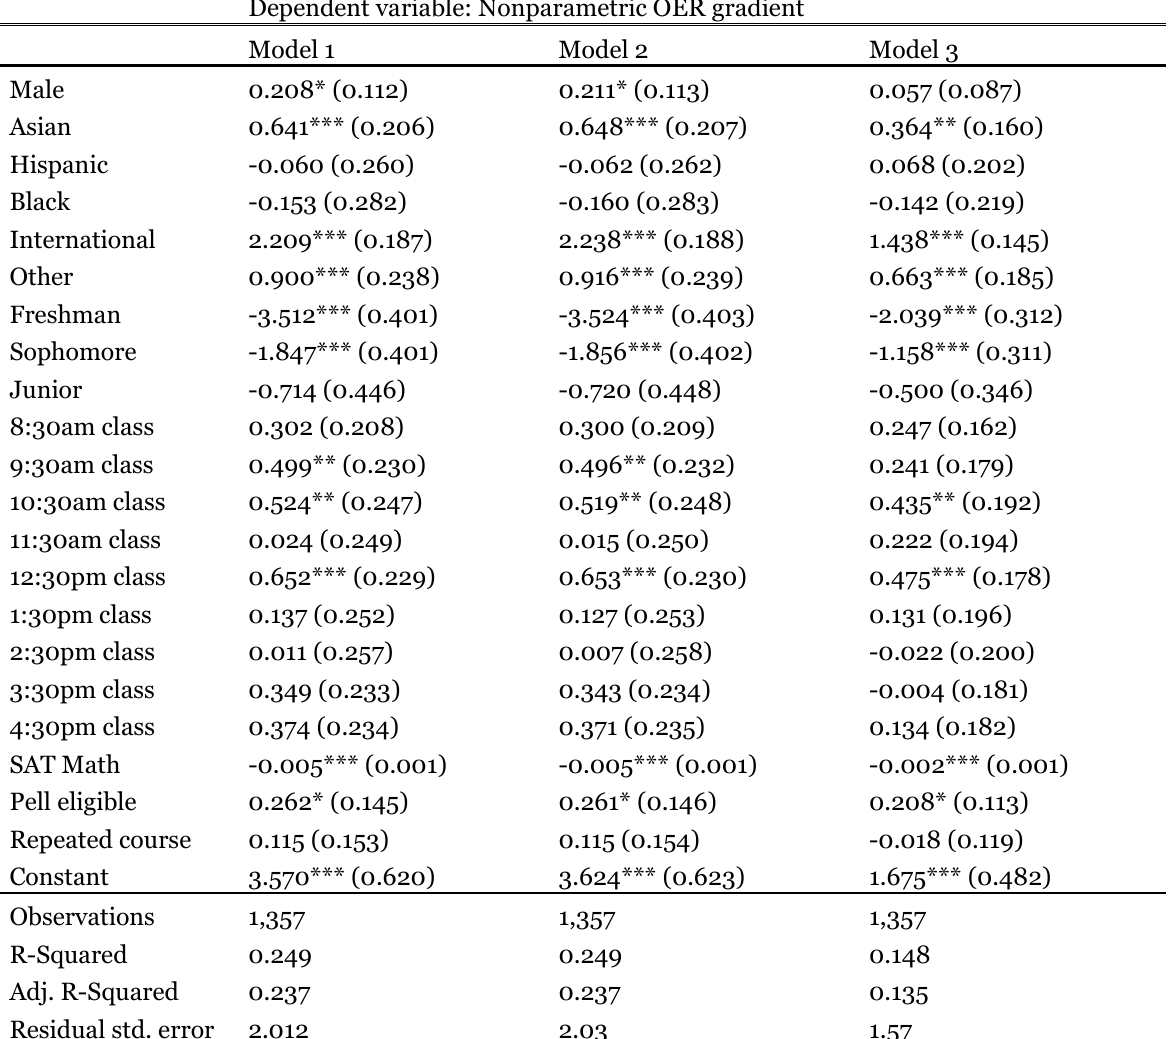
Table 6 Regression of Nonparametric Gradient on Student and Class